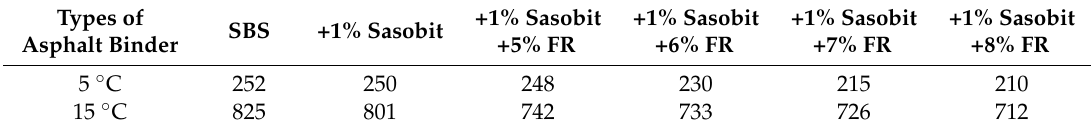
Table 6. Results of ductility test (mm).